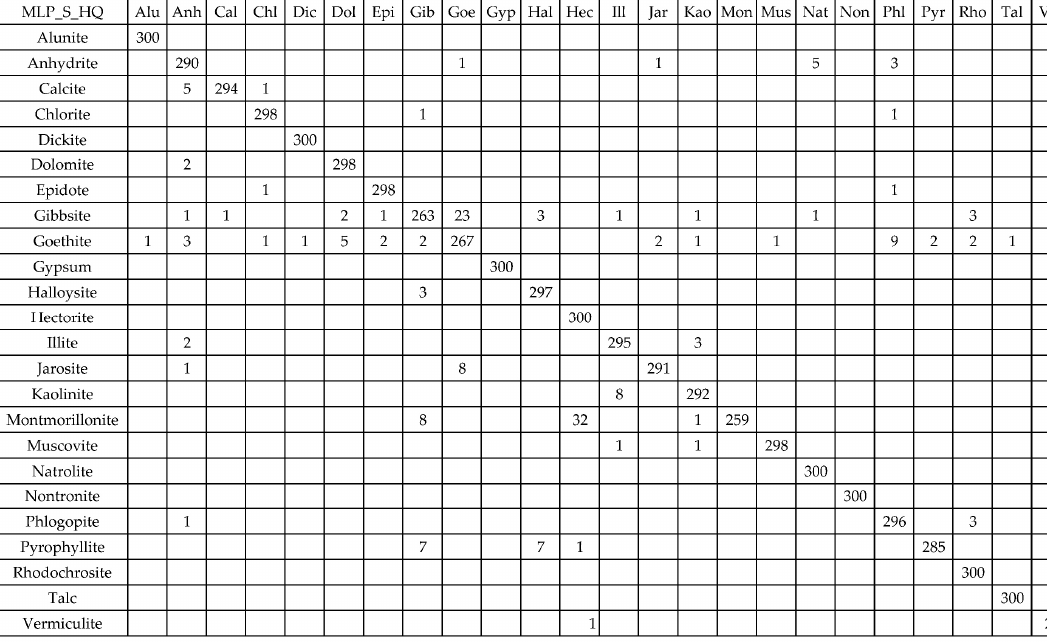
Geosciences 2019 , 9 FOR PEER REVIEW Figure 11. Confusion matrix for MLP_S with HQ for 30 measurements.